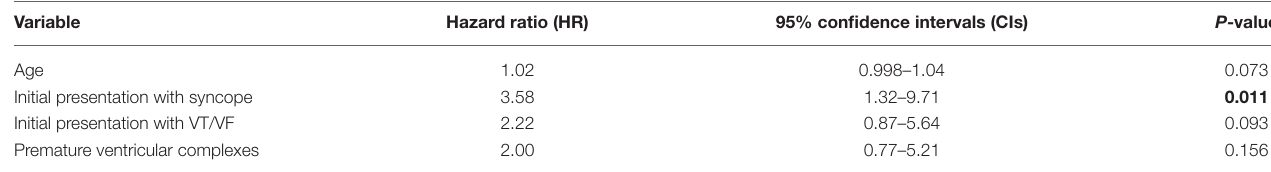
TABLE 2B | Multivariate Cox regression analysis for shorter time to VT/VF post-diagnosis.